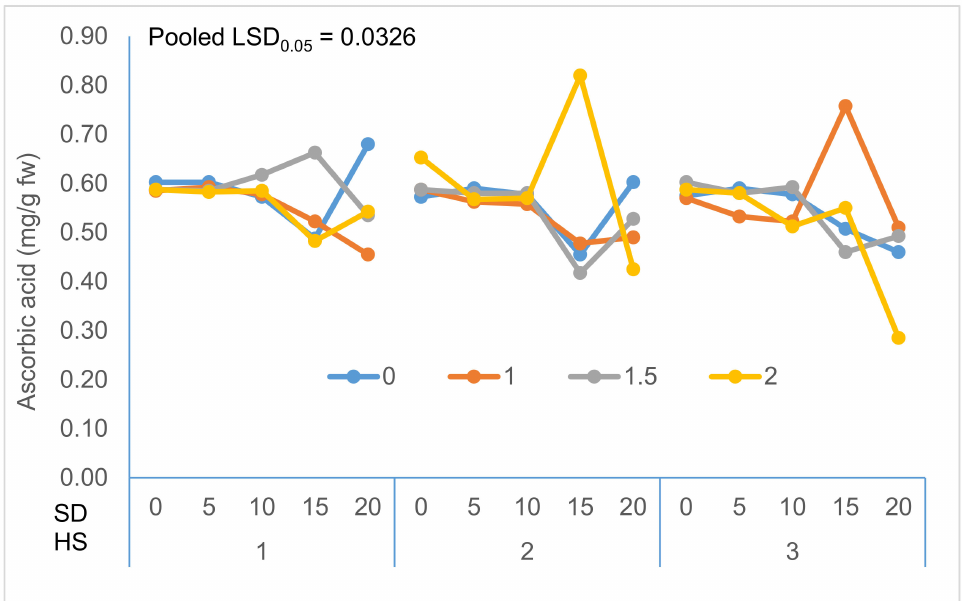
Figure 4. The interaction effects of CaCl 2 (0, 1%, 1.5%, and 2%, w / v ), harvesting stages (HS: 1 = green mature, 2 = breaker and 3 = half ripe) and storage durations (SD: 0, 5, 10, 15 and 20 days) on ascorbic acid content in tomato fruit stored at ambient temperature (28 ± 2 ◦ C and 75 ± 5% RH). Pooled LSD 0.05 =